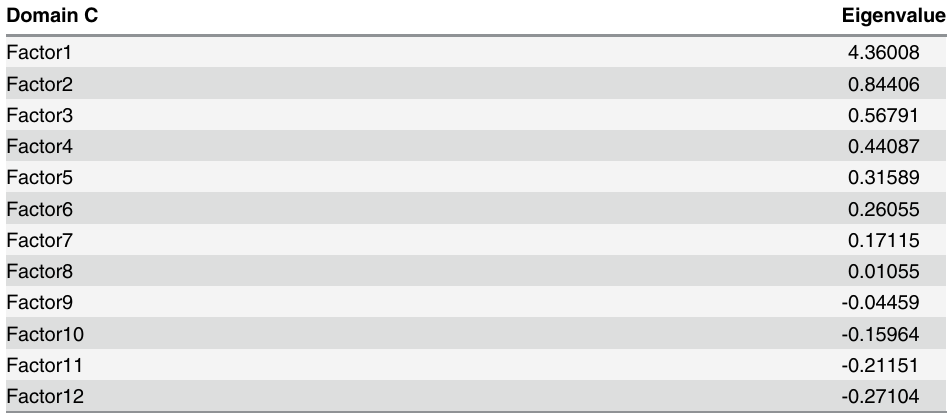
Table 6. Eigenvalues of the domain C in the Osteoporosis Prevention and Awareness Tool (OPAAT) using exploratory factor analysis (EFA).